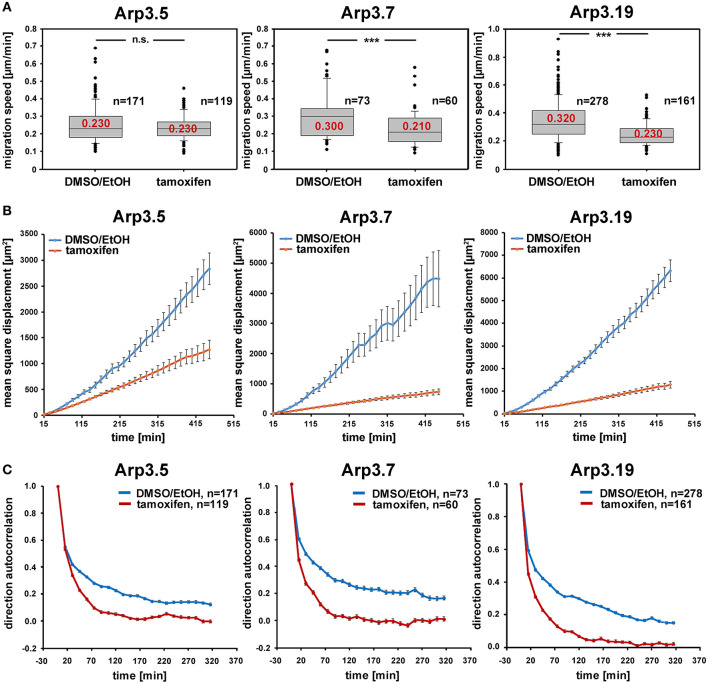
Arp2/3 complex depletion has little effect on the speed of random cell migration, but diminishes efficiency by compromising migration directionality. (A) Random migration speed of Actr3fl/fl clones (Arp3.5, Arp3.7, and Arp3.19, as indicated) with or without treatment with tamoxifen causing acute gene disruption. Data obtained from time-lapse microscopy (20 h) followed by manual tracking of individual cells (for individual cell tracks see Supplementary Figure 9). Box and whiskers plots were as described for Figure 4B, and data derived from three independent experiments. n = total number of cells analyzed. Non-parametric Mann-Whitney rank sum test was used for statistical comparison of respective groups (***p < 0.001). (B) Mean square displacement analysis of the same data as shown in (A), revealing the strong decrease in migration efficiency upon Arp3 depletion in spite of the limited impact on speed. (C) Analysis of directional migration utilizing trajectories from (A) and shown in Supplementary Figure 9. An autocorrelation of 1 corresponds to strictly directed movement whereas an autocorrelation of 0 corresponds to pure random walk. Note the rapid and consistent loss of directional migration upon Arp2/3 complex removal (tamoxifen) in these experimental conditions in all three cell clones. Data are displayed as direction autocorrelation curves with error bars representing standard errors of means.